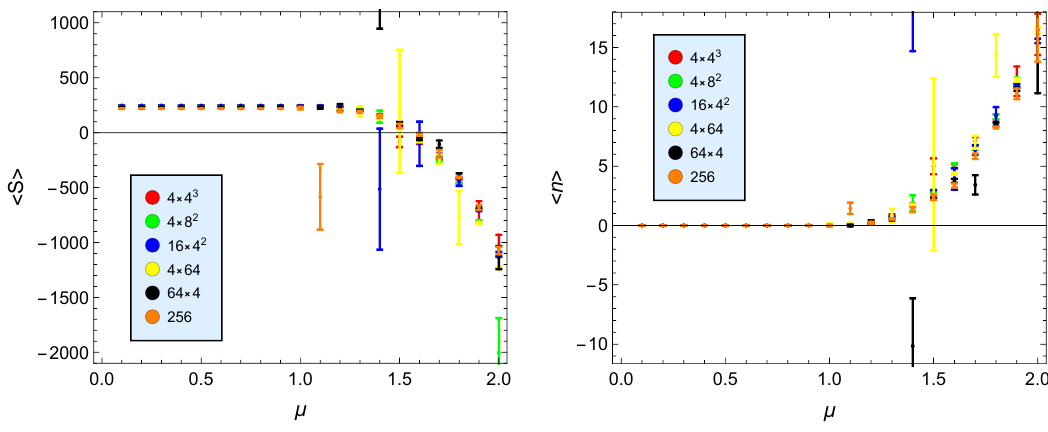
Figure 14 . The expectation values of the action (left) and the density (right) as a function of µ for lattices with 256 sites at various dimensions for m = 1 evaluated using the simple first order contour. The lattices are identified as L × ˜ L d − 1 . The curves almost coincide up to errors coming from the sign problem at large values of µ